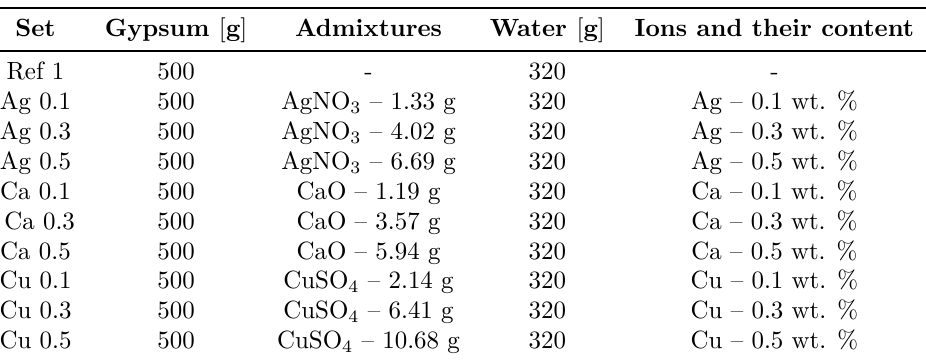
Table 1. Composition of tested sets.